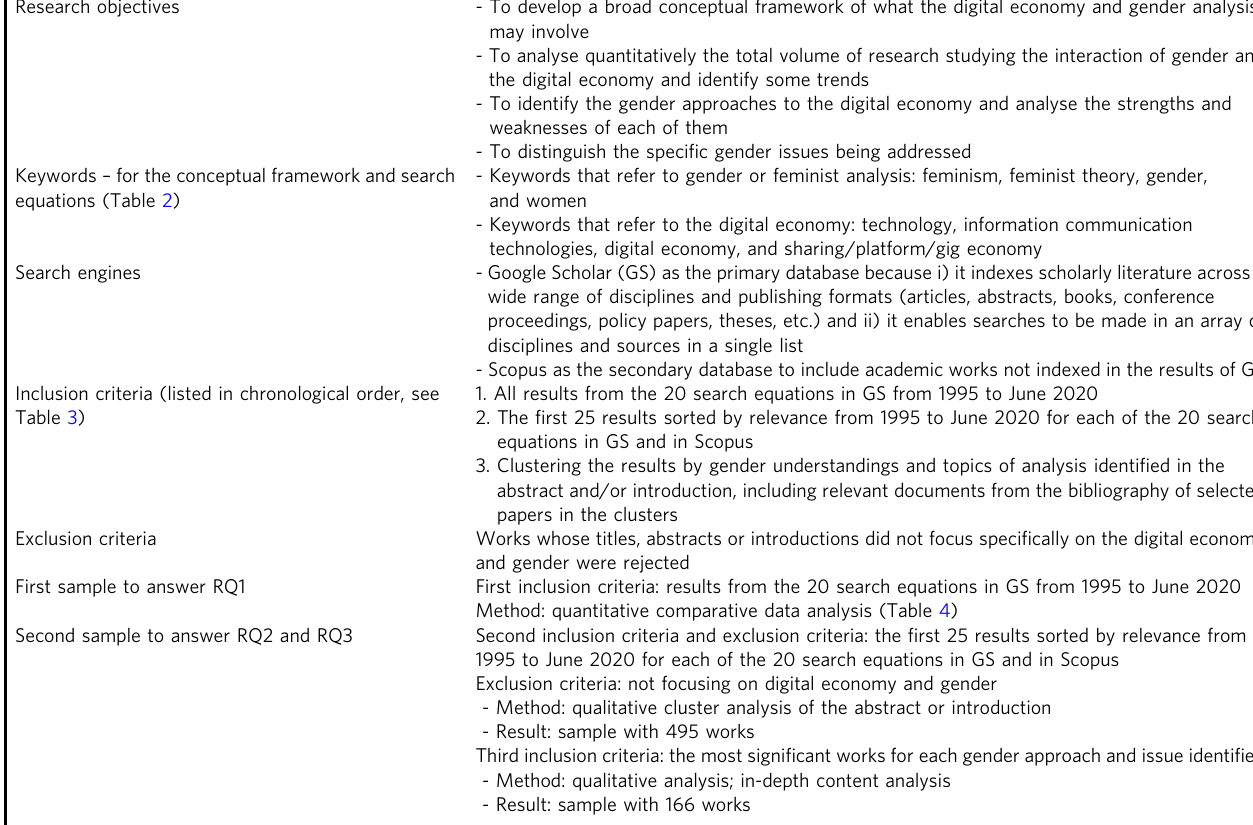
Table 1 Methodology used in the paper to answer each of the speci fi c questions. Research objectives - To develop a broad conceptual framework of what the digital economy and gender analysis may involve